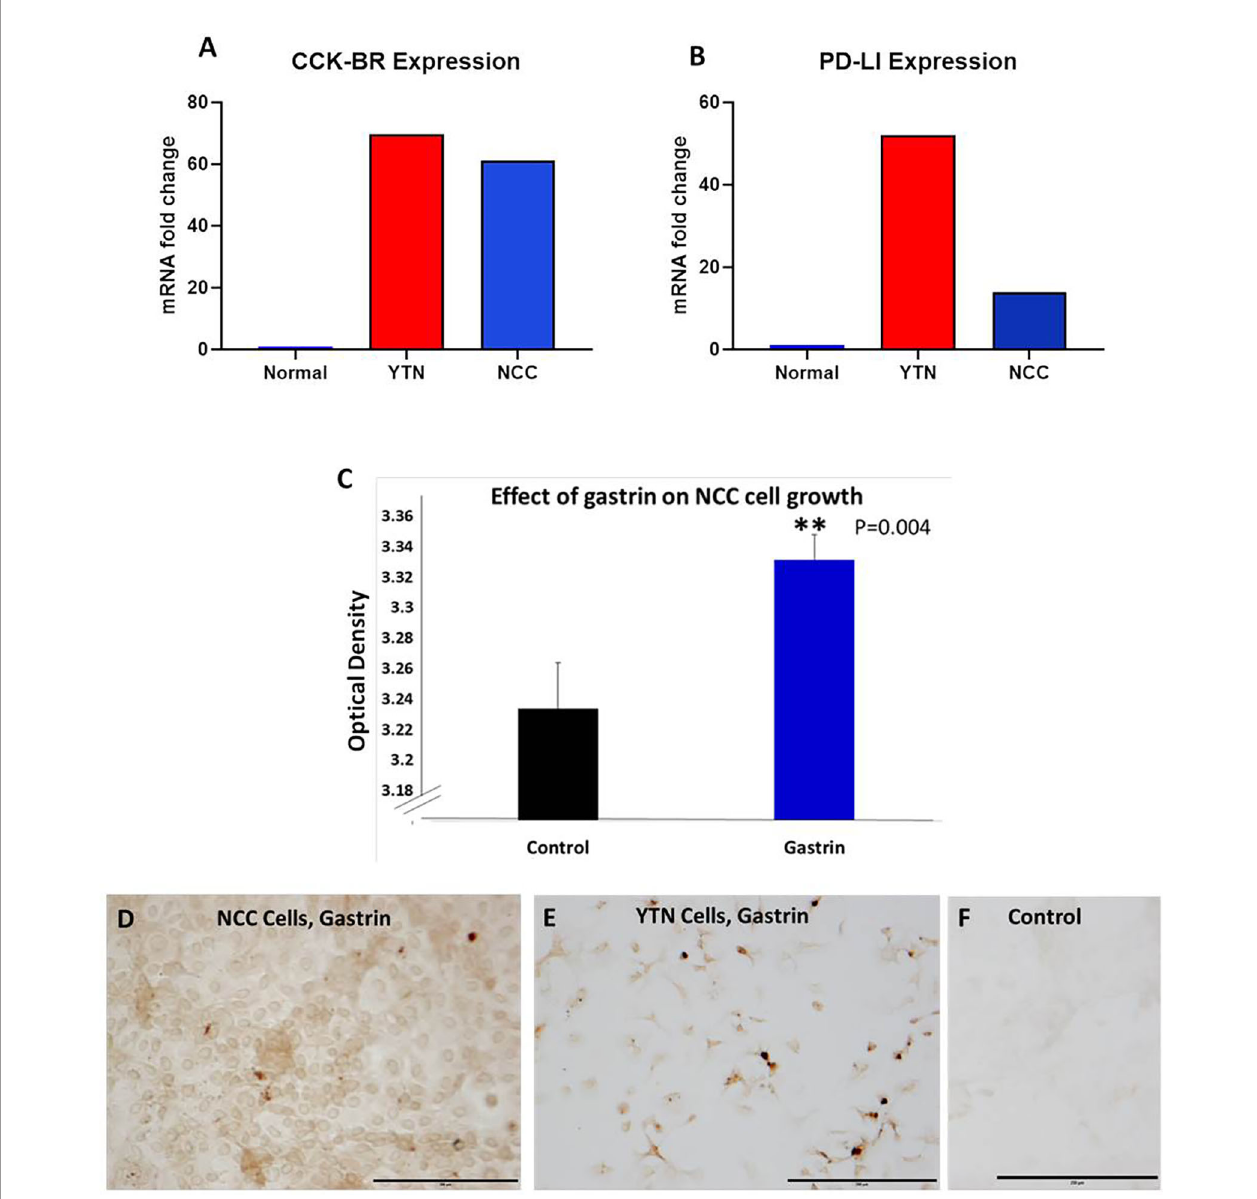
FIGURE 2 | Characterization of murine gastric cancer cells in vitro . (A) mRNA expression of CCK-BR is increased greater than 60-fold in YTN and NCC gastric cancer cells compared to normal mouse tissue. (B) mRNA expression by qRT-PCR of PD-L1 is markedly increased in gastric cancer YTN and NCC cells compared to normal tissues. (C) Exogenous gastrin stimulates growth of murine NCC gastric cancer cells in vitro (P = 0.004). **Signi fi cantly different from control. (D) Gastrin peptide expression is detected in NCC gastric cancer cells. (E) Gastrin peptide expression is detected in YTN gastric cancer cells. (F) Control cells stained with the secondary antibody only show no evidence of nonspeci fi c immunoreactivity. Scale bar 200 m